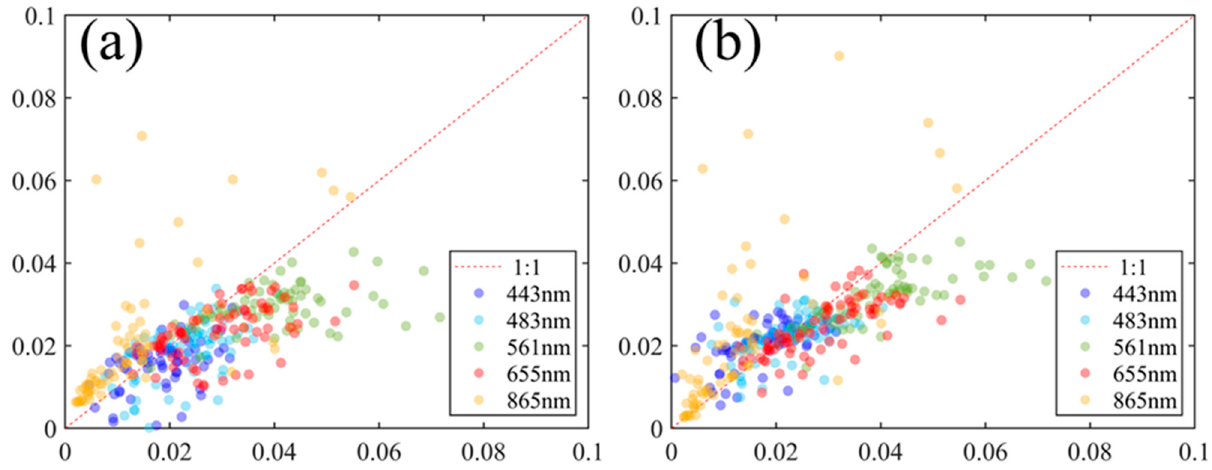
Figure 9. Sca tt erplots of R rs derived by the ACZI ( a ) and the m-ACZI ( b ) algorithms versus in situ R rs . Table 1. Statistics of the accuracy measures for the ACZI and the m-ACZI algorithms using in situ R rs measurements. The BLUE number represents the minimal statistical value.